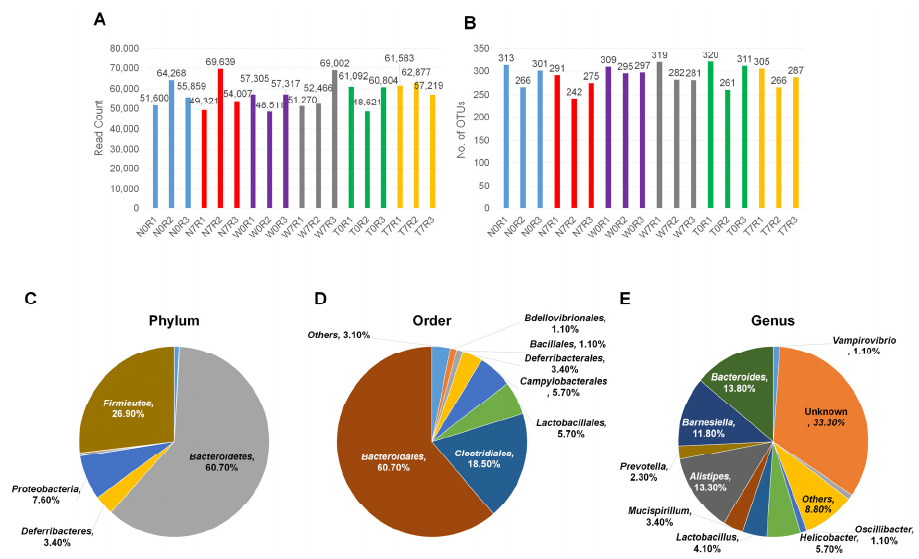
Figure 2. Analyses of sequenced reads in each library and assignment of all filtered reads according to bacterial taxonomy. (A) Number of analyzed reads in each library, (B) number of identified operational taxonomic units (OTUs) in each library, (C-E) taxonomical classification of all analyzed reads from 18 libraries according to phylum (C), order (D), and genus (E). 18 libraries according to phylum ( C ), order ( D ), and genus ( E ). Genes 2017 , 8 , x FOR PEER REVIEW